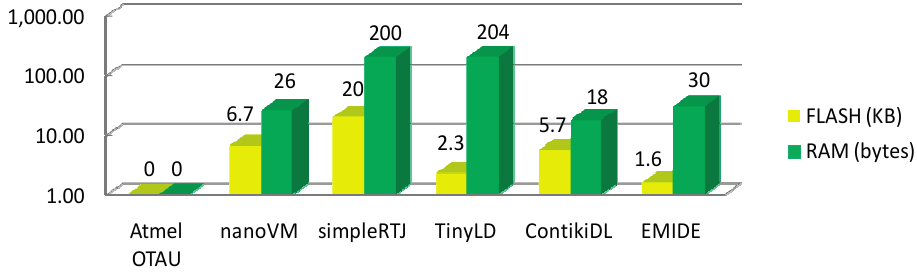
Figure 12. Memory cost of the EJVM, the DLM, the EMIDE and the Atmel OTAU.